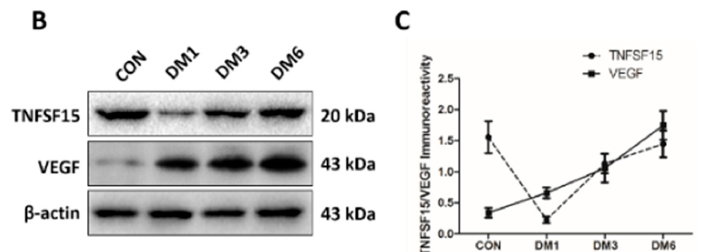
Figure 2. The expression of TNFSF15 and VEGF in the retina of normal rats and diabetic rats with different diabetes duration. ( A ) Typical images of TNFSF15 and VEGF immunostaining in the retina. Arrows indicate TNFSF15 ( upper panel) or VEGF ( lower pane) expression in the retina. Magnification, 400×; ( B ) A representative Western blot is shown; ( C ) Image of Western blot analysis is shown: TNFSF15 significantly decreased in the DM1 group compared with the CON group ( p < 0.001), then increased gradually, with no difference between the DM6 group and the CON group ( p = 0.351); VEGF expression increased significantly as the duration of diabetes was prolonged.